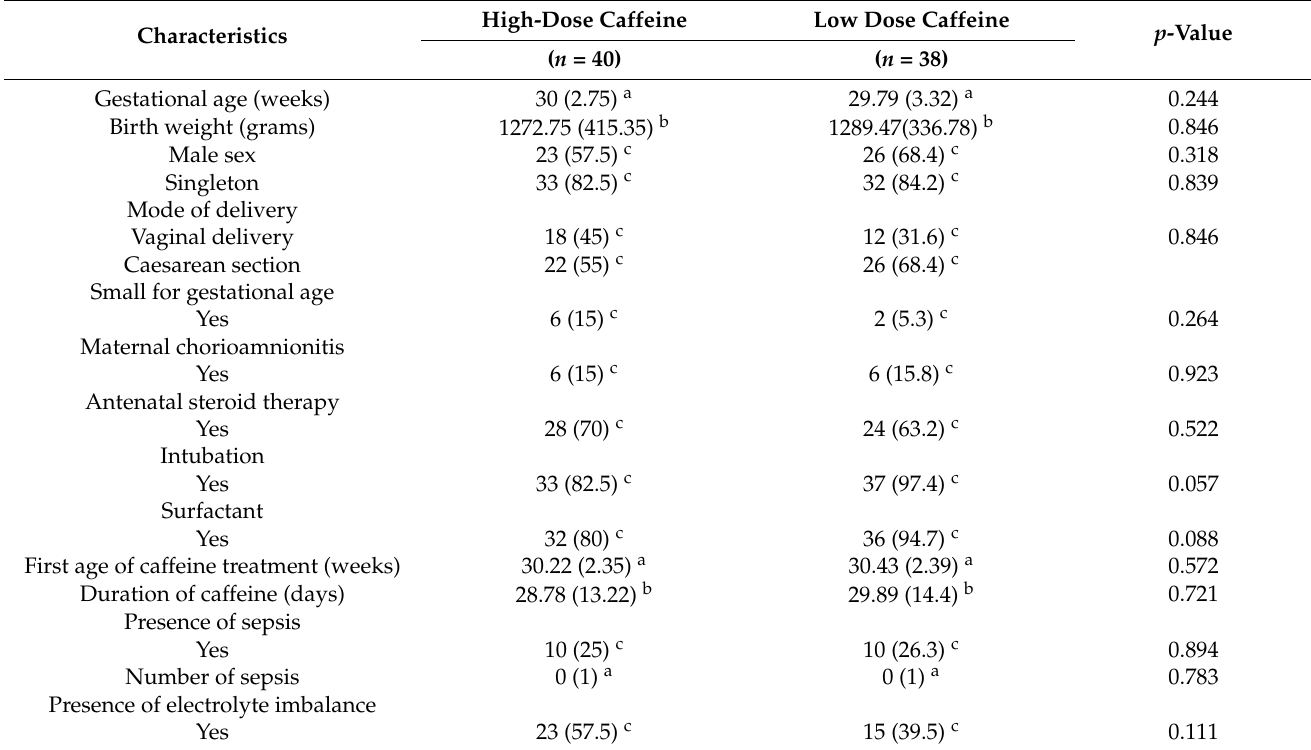
Table 1. Baseline characteristics of the studied group ( n =